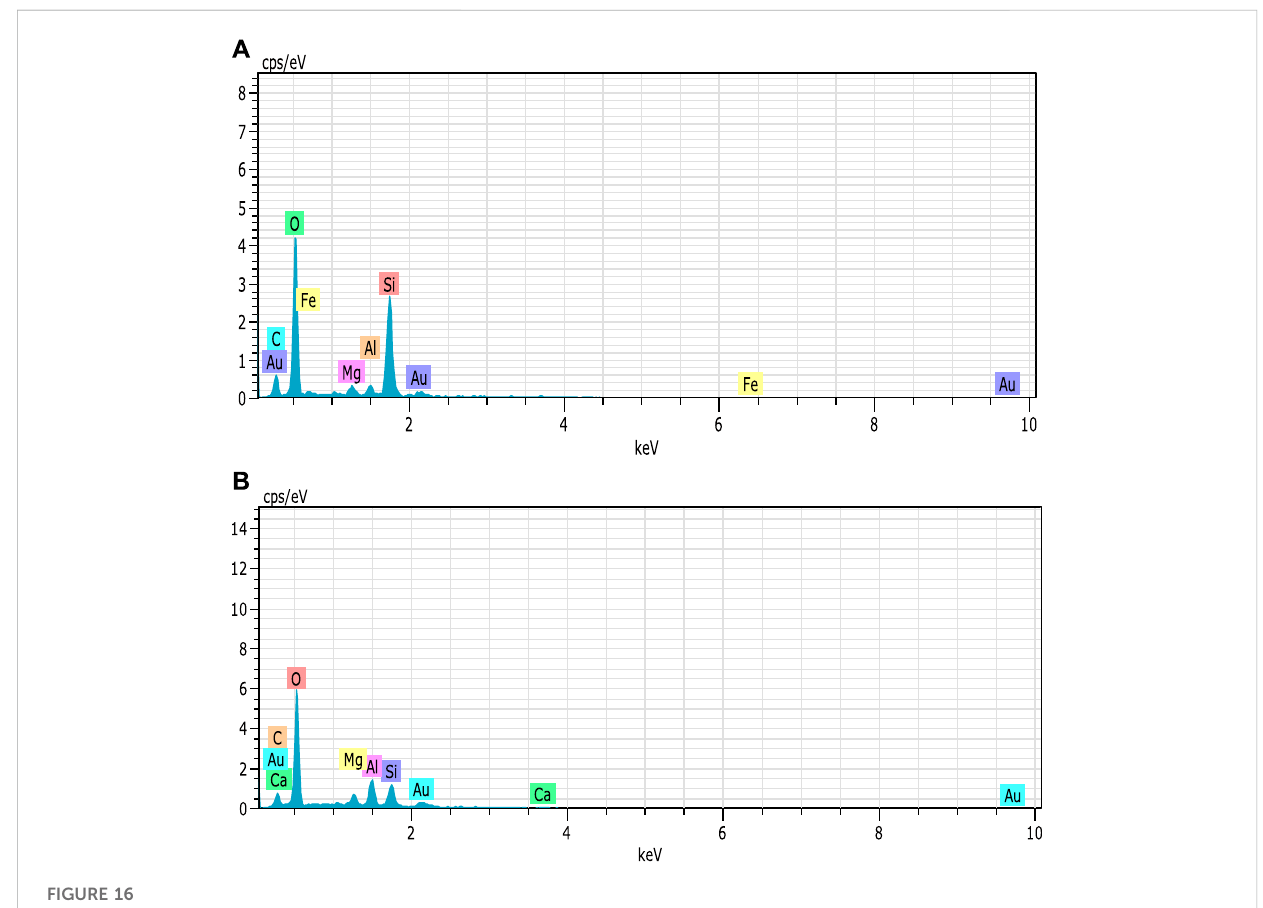
FIGURE 16 EDS patterns of (A) sugar cane bagasse ash; (B) blast furnace